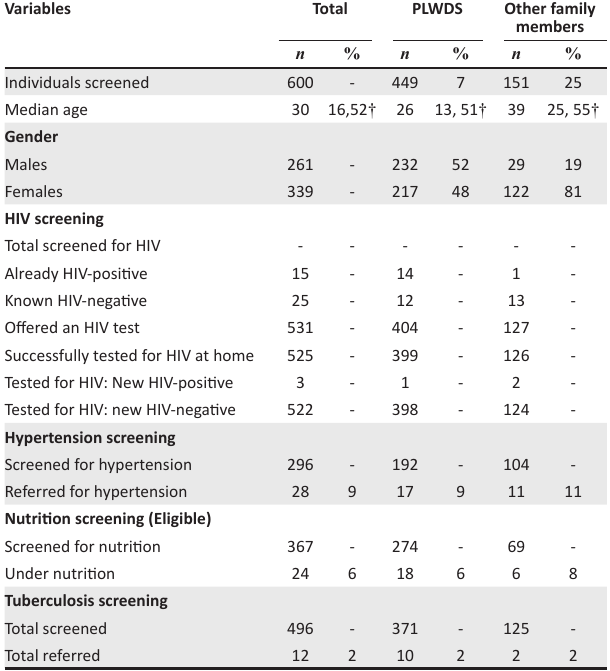
TABLE 3: Characteristics of patients screened using home-based integrated testing. Variables